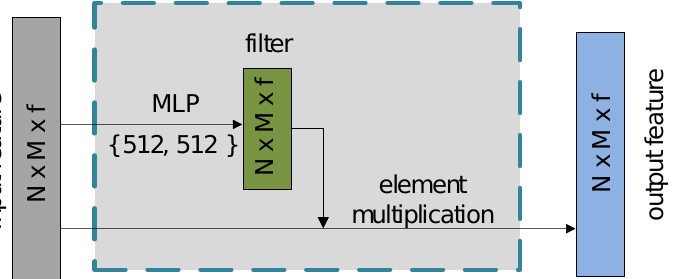
Figure 4. RelationConv operation structure. Assume that frame t and frame t − 1 include N and M detected objects (nodes), respectively. The proposed RelationConv operation takes N × M nodes with f -dimension features as input. An MLP subnetwork is then employed to learn a flexible filter, which applies an element multiplication operation over the input feature to obtain the semantic